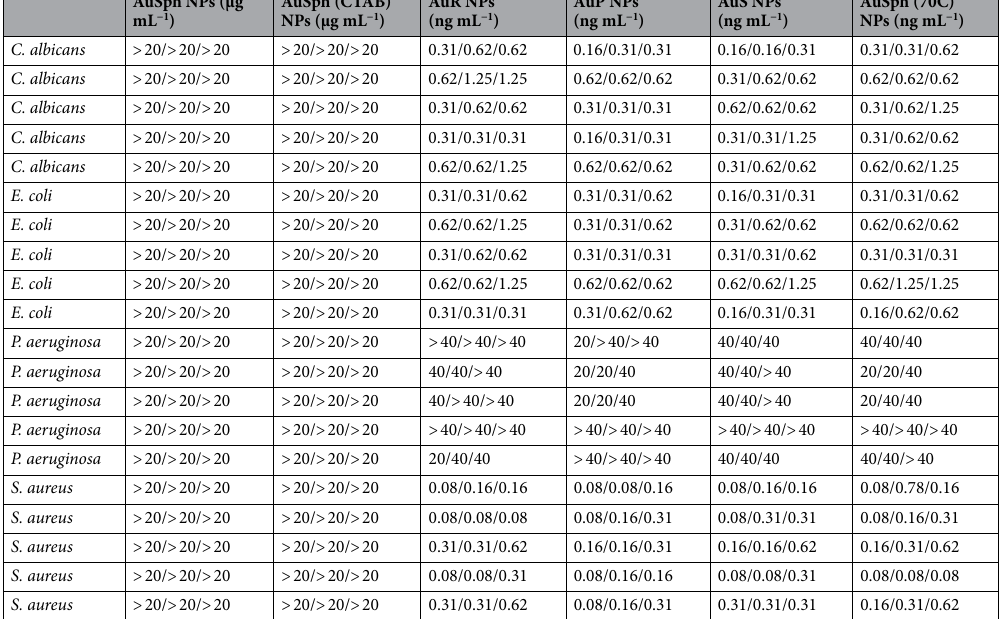
Table 1. Minimal inhibitory concentrations (MIC; ng mL −1 or µg mL −1 ), minimal bactericidal/fungicidal concentrations (MBC/MFC; ng mL −1 or µg mL −1 ) and minimal biofilm inhibitory concentrations (MBIC; ng mL −1 or µg mL −1 ) of varied-shaped gold nanoparticles against C. albicans, E. coli, P. aeruginosa and S. aureus